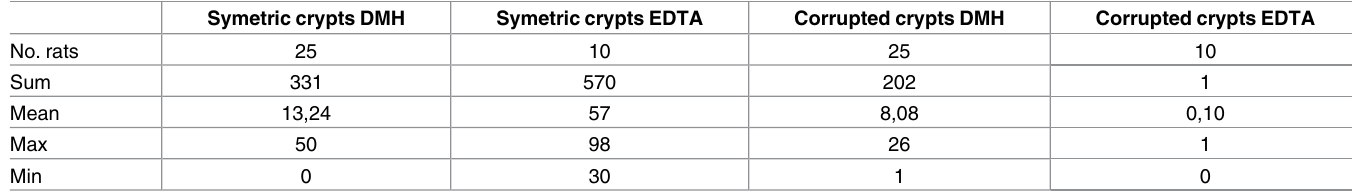
Table 1. The number of colonic crypts with symmetricfission and with corrupted fission in 35 male rats: 25 Sprague-Dawley (SD) rats injected for 27 weeks with 1,2 Dimethylhydrazine (DMH) suspended in EDTA, and 10 male SD rats injected with EDTA for 27 weeks.